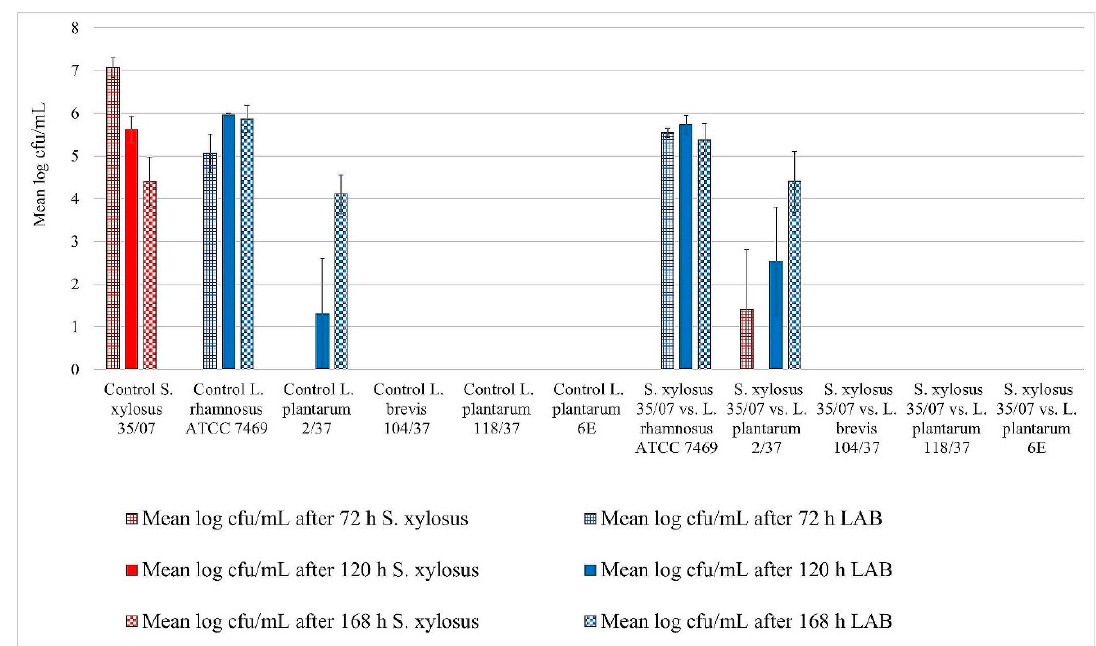
Figure 1. Biofilm challenge: Staphylococcus aureus ATCC 12,600 vs. lactic acid bacteria (LAB). Cfu/mL values are shown transformed by log (± standard error of the mean).